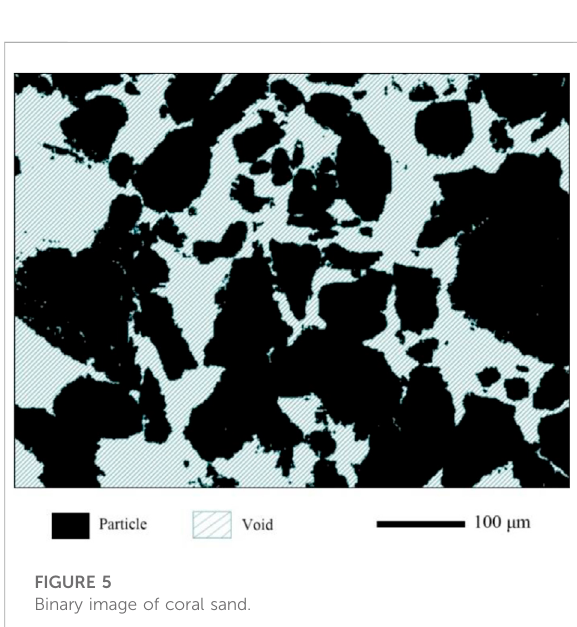
FIGURE 5 Binary image of coral